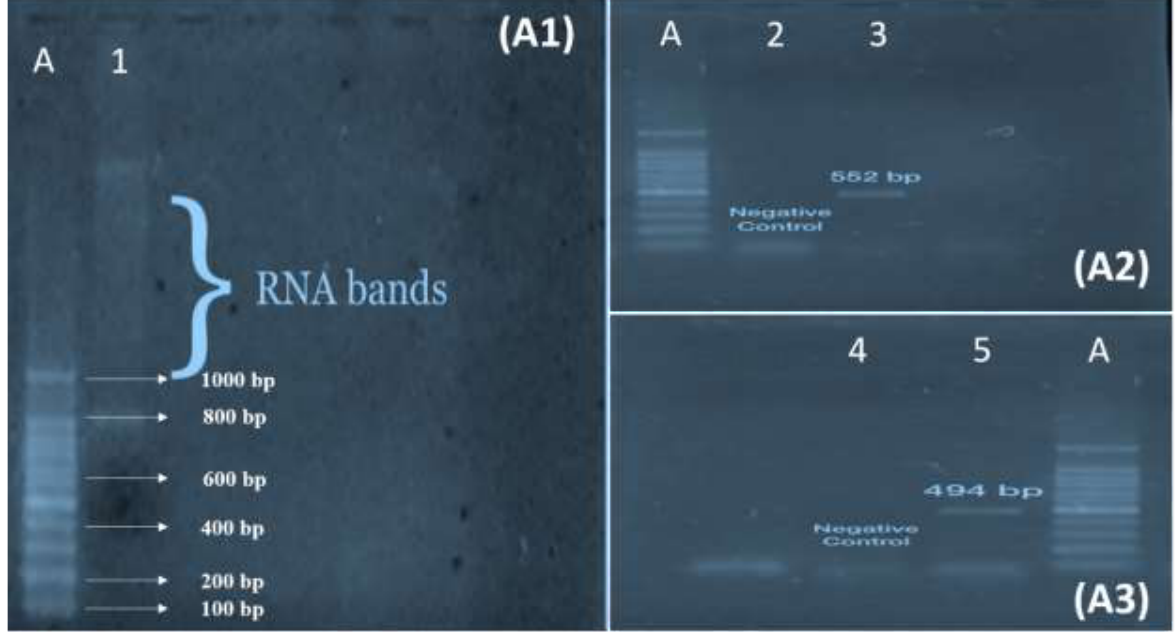
Figure 1. A: 100 bp RNA Ladder. ( A1 ): Agarose 1% gel electrophoresis of HIV-1 RNA. 1: Bands of RNA. ( A2 ): Agarose 2 % gel electrophoresis of glycoprotein GP41 F2 of HIV Envelope gene PCR products. 2: Negative Control. 3: Positive bands for 2nd fragment of GP41. ( A3 ): Agarose 2 % gel electrophoresis of glycoprotein GP41 F1 of HIV Envelope gene PCR products. 4: Negative Control. 5: Positive bands for 1st fragment of GP41.